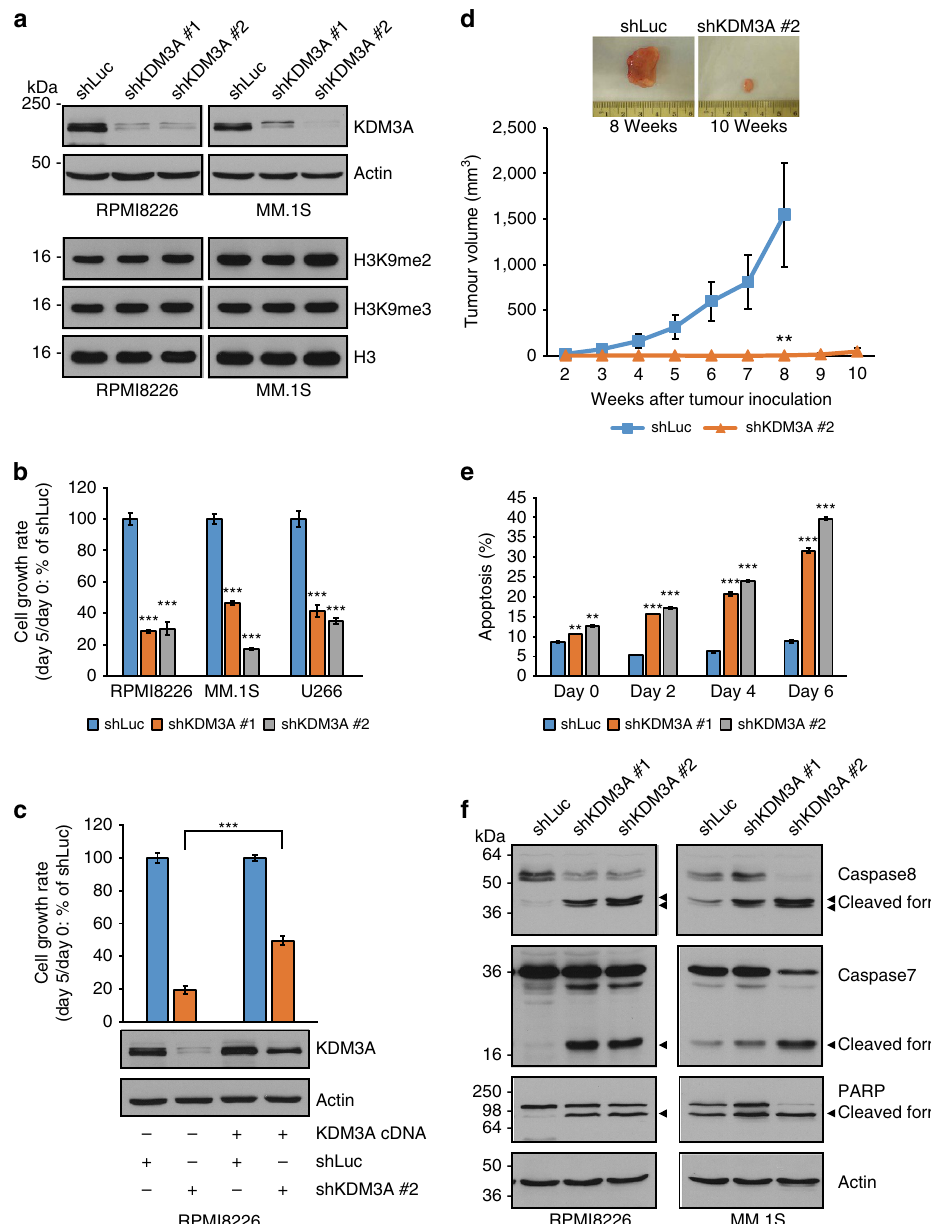
MM.1S Figure 2 | KDM3A is indispensable for the survival of MM cells. ( a ) Immunoblot analysis of KDM3A, H3K9me2 and H3K9me3 in KDM3A -knockdown RPMI8226 and MM.1S cells. Cells were transduced with either KDM3A -specific shRNA (shKDM3A #1 and #2) or shLuc by lentivirus. Whole-cell lysates were subjected to immunoblot analysis. Actin or H3 served as the loading control for each membrane. ( b ) MM cell lines (RPMI8226, MM.1S and U266) were transduced with shKDM3A or control shLuc. Three days post infection, which was designated as day 0, cells were plated in 96-well plates. Cell viability was measured on days 0 and 5 by MTTassay, and the cell growth rate (day 5/day 0) relative to shLuc was determined. ( c ) RPMI8226 cells were retrovirally transduced with the KDM3A cDNA carrying synonymous mutations in the shKDM3A #2 target sequence or with empty vector. Cells stably expressing the KDM3A cDNA or empty vector were then lentivirally transduced with shKDM3A #2 or shLuc. The cell growth rate (day 5/day 0) after lentiviral infection was determined for shKDM3A relative to shLuc. The growth rate for control shLuc in each cell type expressing the KDM3A cDNA or empty vector is set as 100%. ( d ) MM.1S cells transduced with shKDM3A #2 or shLuc (4 (cid:2) 10 6 viable cells) were subcutaneously injected into SCID mice. Data represent mean ± s.e.m. n ¼ 7 mice per group. An image of a representative tumour in each group is shown (top panel). ( e ) Apo2.7 immunostaining in RPMI8226 cells after knockdown of KDM3A . Cells were analysed 3 days post infection (day 0) and on days 2, 4, 6 for apoptosis by measuring apo2.7-positive cells. ( f ) Immunoblot analysis of caspase 8, caspase 7 and PARP in whole-cell lysates from KDM3A -knockdown RPMI8226 and MM.1S cells. Arrowheads indicate cleaved form. Actin served as the loading control. For b , c , e , data represent mean ± s.d. of quintuplicate cultures ( b , c ) or duplicate cultures ( e ). For a – c , e , f , data are representative of at least two independent experiments. ** P o 0.01, *** P o 0.001 compared with control; Student’s t MM.1S cells (Fig. 2a and Supplementary Fig. 2a). Although cells transduced with KDM3A -specific shRNAs, similar to short KDM3A is a demethylase specific to H3K9me1 and me2 (ref. 7), interfering RNA-mediated KDM3A knockdown in HeLa cells 32 the global H3K9me2 level was not significantly increased in MM (Fig. 2a). Importantly, knockdown of KDM3A significantly